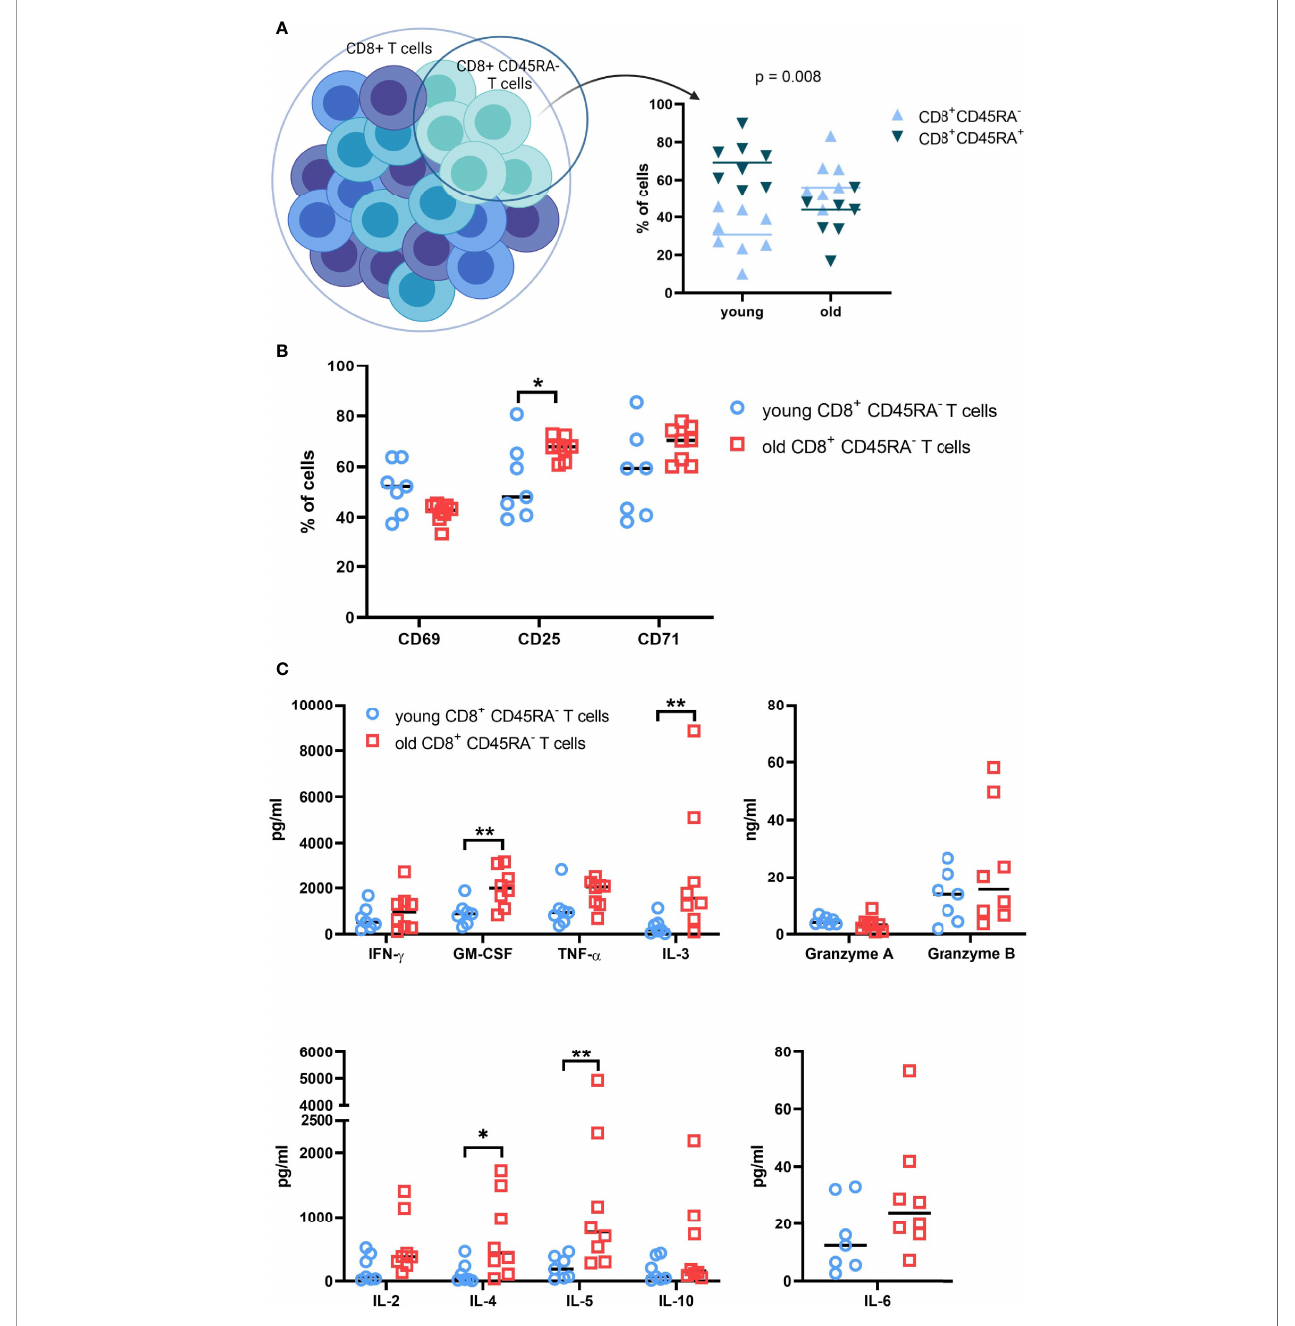
FIGURE 2 | Functional analysis of T cell subpopulations subjected to RNA sequencing. (A) . Composition of the total CD8 + T cell populations of young and old donors. Pre-sort distribution of the CD8 + CD45RA - memory T cell subpopulation within the total CD8 + T cell population preparations were determined with fl ow cytometry. N = 8. (B) . Expression of activation markers on CD8 + CD45RA - memory T cell subpopulations. The surface expression of common activation markers was measured after 48h. N = 8. * = p value < 0.05, ** = p value < 0.01. (C) . Soluble-protein secretion patterns of CD8 + CD45RA - T cells from young and old donors. Soluble proteins were measured in the supernatant after 2 days of culture with a CBA Flex Set from BD Biosciences. The kit contains granzymes A and B, IFN- g , TNF- a , GM-CSF, IL-10, IL-6, IL-5, IL-4, IL-3, and IL-2. N=8; * = p value < 0.05, ** = p value <